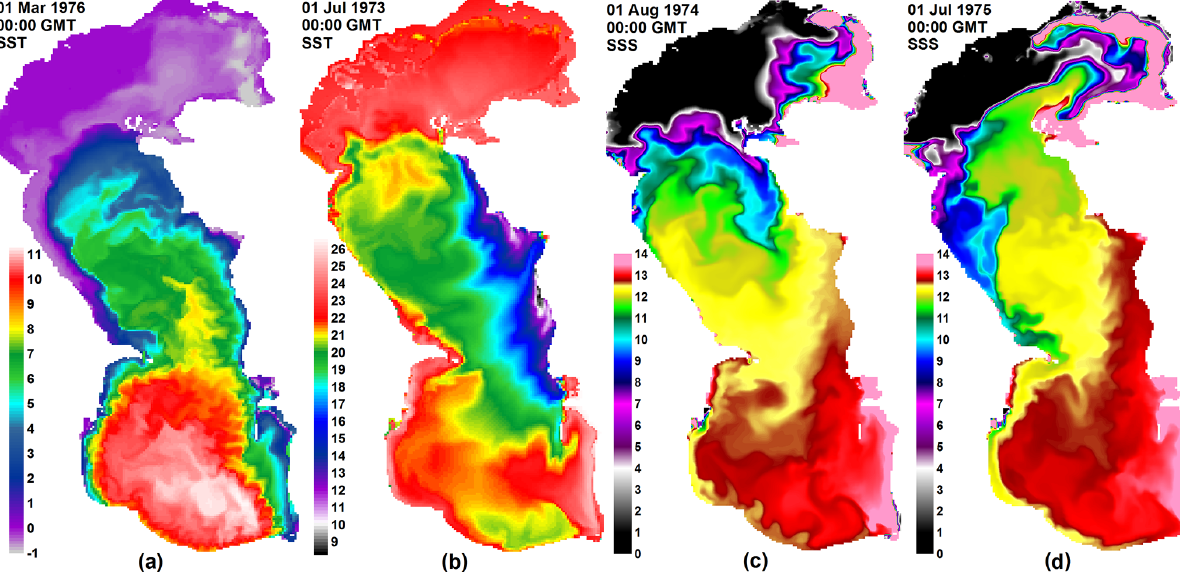
Figure 4. Model instantaneous sea surface temperature (SST) and salinity (SSS): (a) SST ( ◦ C) on 1 March 1976; (b) SST ( ◦ C) on 1 July 1973; (c) SSS (psu) on 1 August 1974; (d) SSS (psu) on 1 July